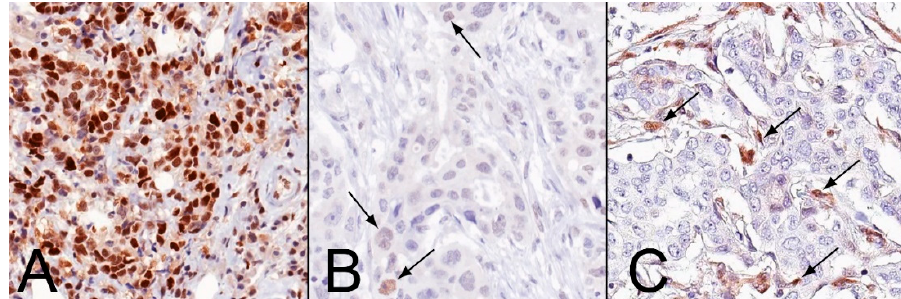
Figure 4. Patterns of MMR protein expression. ( A ). Proficient status in the presence of retained